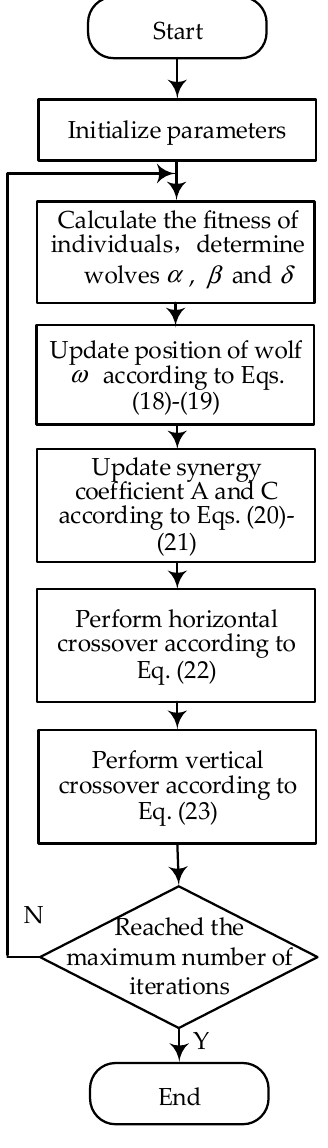
Figure 5. The flow chart of CS-GWO.